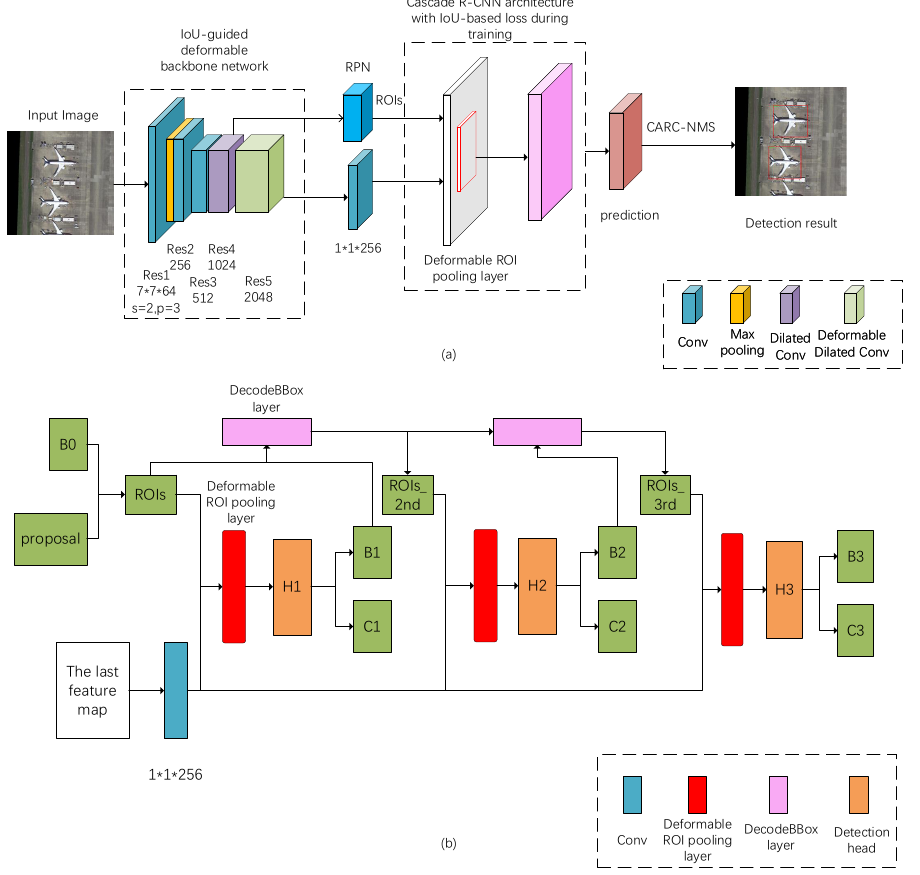
Figure 3. ( a ) An overview of the IoU-Adaptive Deformable R-CNN ( b ) The deformable Cascade R-CNN architecture. We set the IoU threshold value of detection head H1, H2, H3 to 0.4, 0.5, 0.6 respectively in our framework. “H” network head, “B” bounding box offset, and “C” classification. “B0” is offset of proposals in image ( b